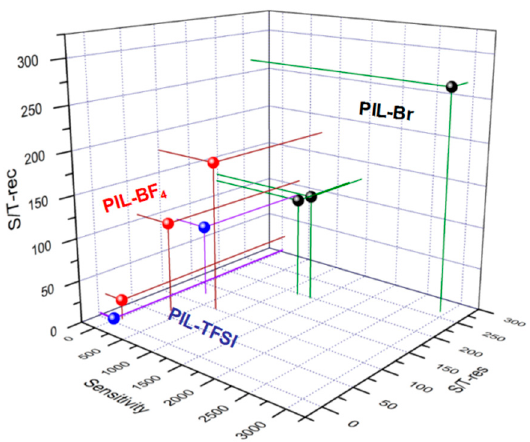
Figure 9. Response of sensors based on PILs(PIL-Br, PIL-BF 4 and PIL-TFSI) at the working frequency. Table 1. The performance parameters of the as-prepared PIL-based humidity sensors.